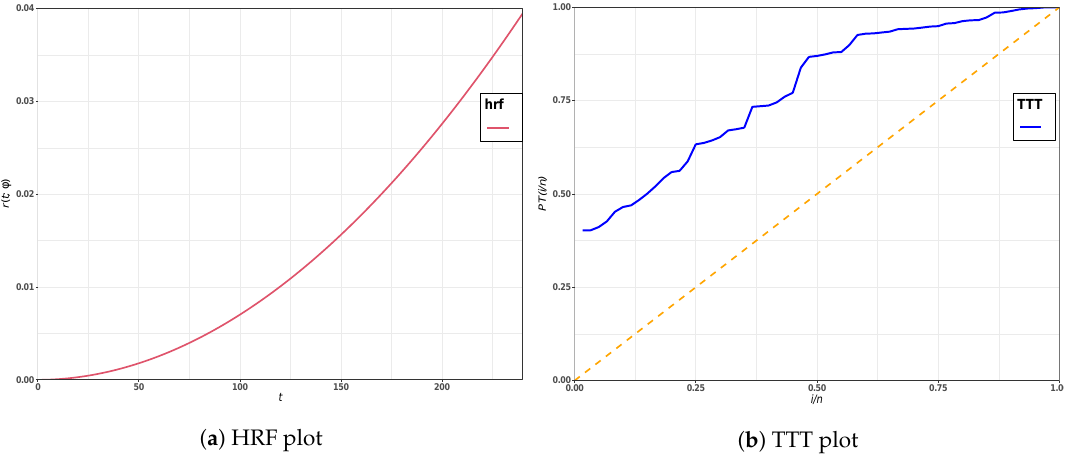
Figure 5. The hazard rate function (HRF) plot of the GRL distribution and TTT plot for leukemia data.